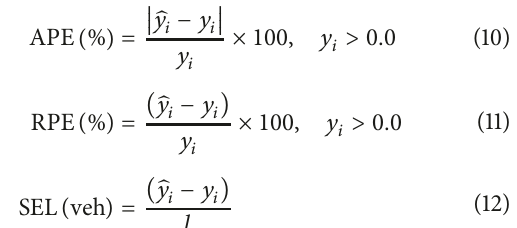
of the presented method. APE, RPE, and SEL are expressed